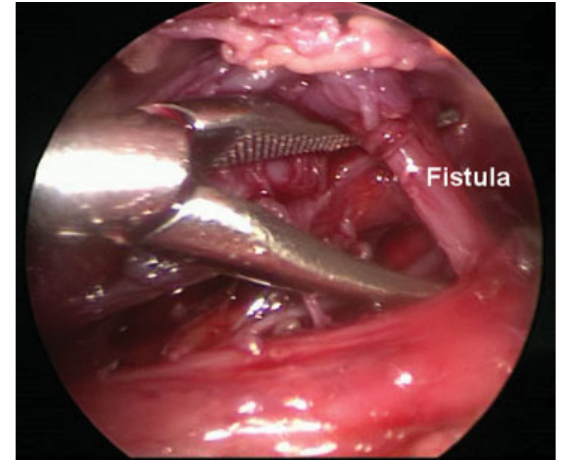
Fig. 1 Intraoperative image of the fi rst surgery demonstrating the very small fi stula size.